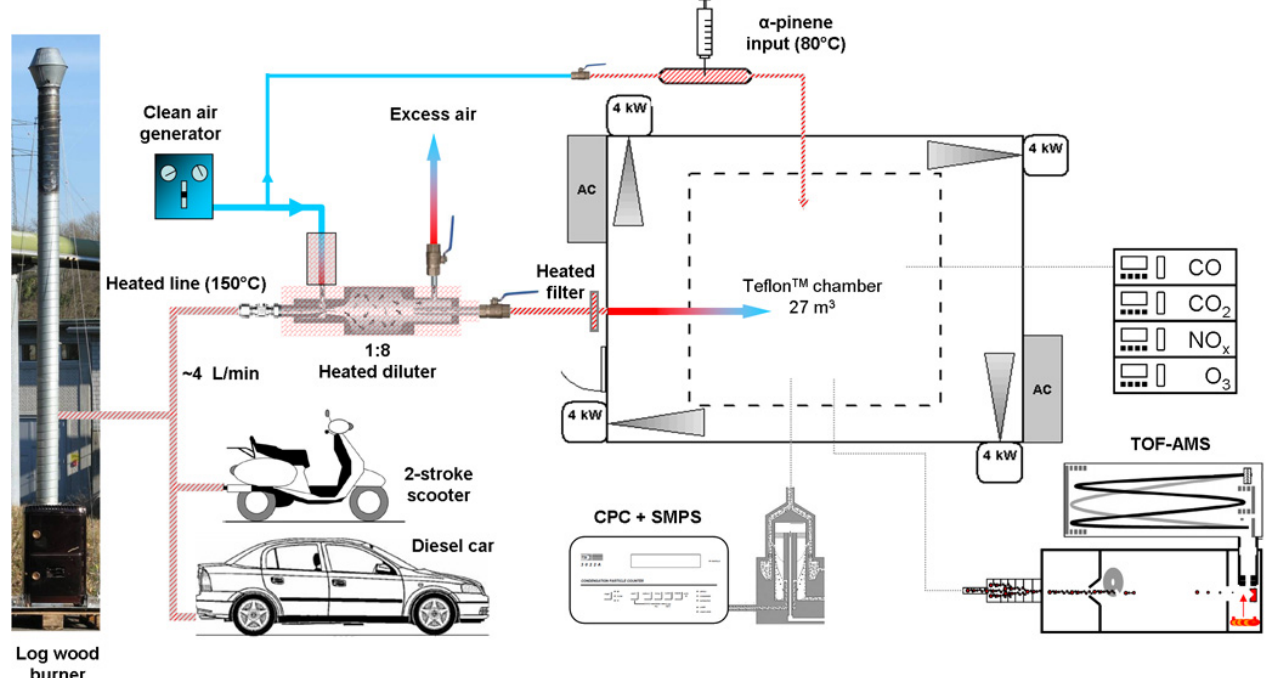
Fig. 1. Schematic representation of the inlet system and smog chamber